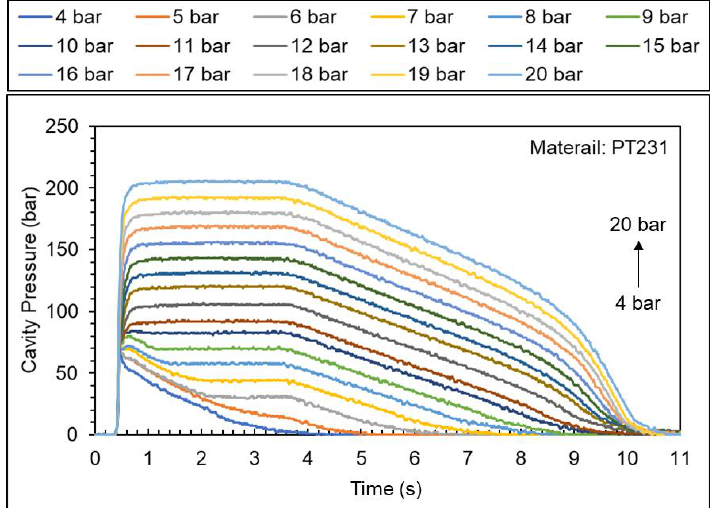
Figure A3. Cavity pressure profiles of PT231 at different packing pressures.